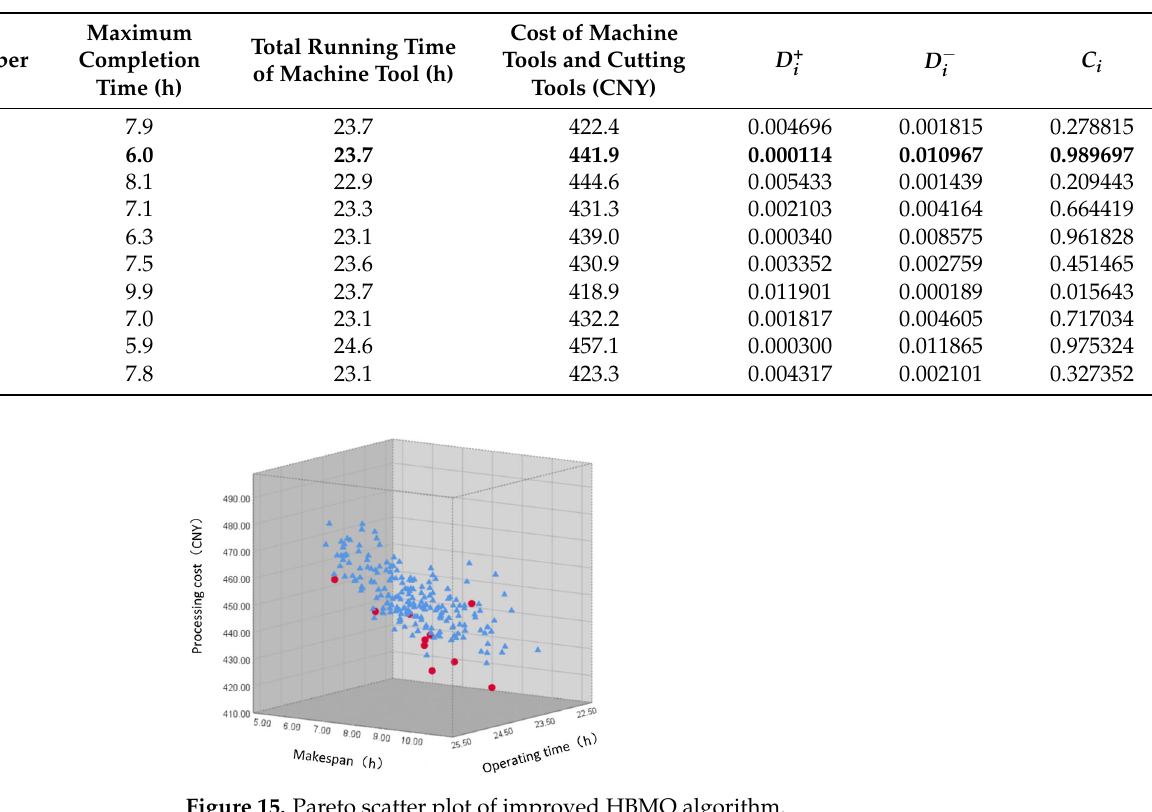
Table 8. Evaluation of process reconfiguration scheme based on TOPSIS evaluation method.